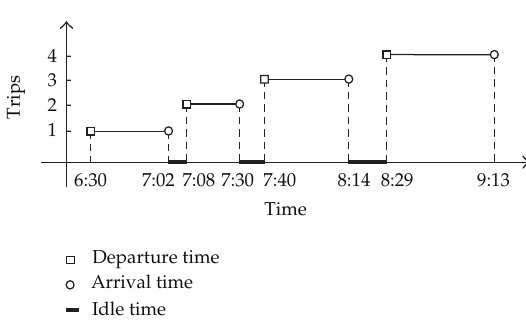
Figure 1: The crew idle time with four